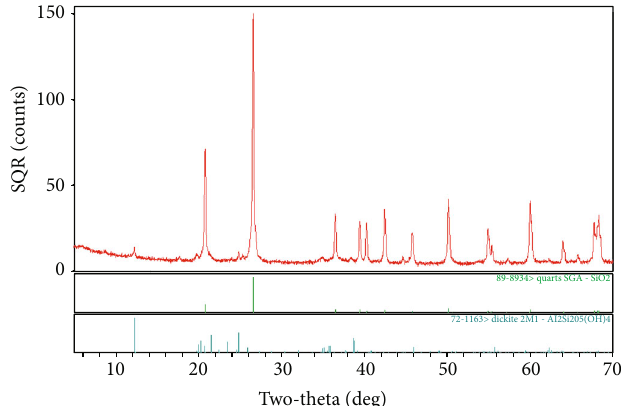
Figure 3: XRD test results of rock specimens